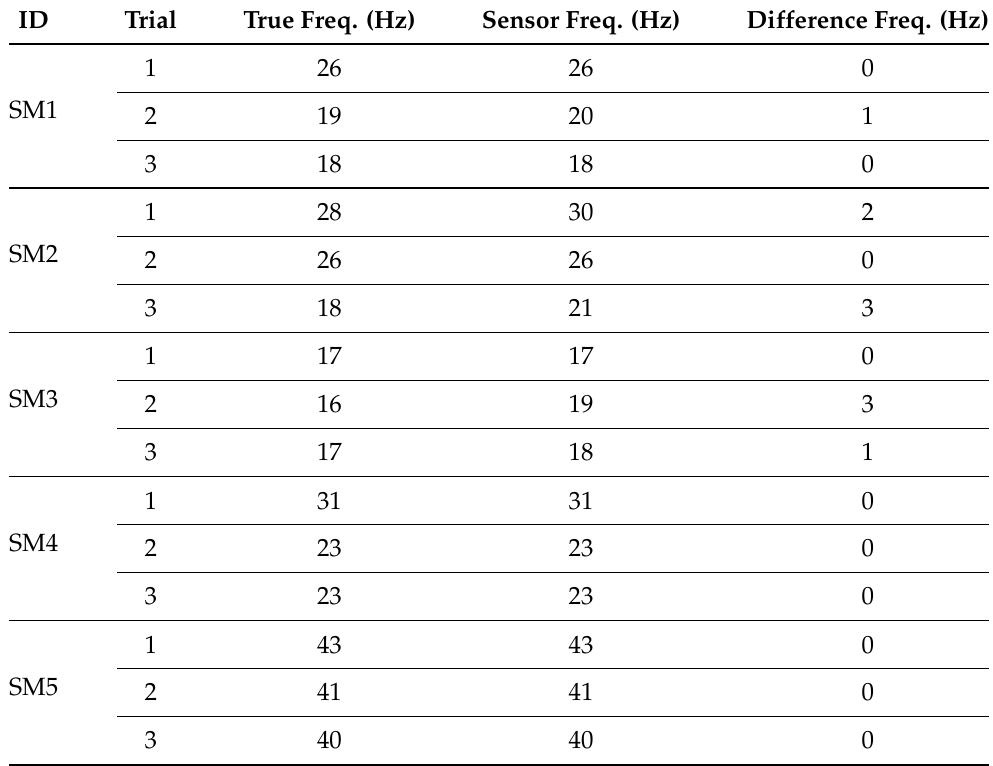
Table 2. Comparison between the frequency response of the sensor to the actual wingbeat frequency of silk moths obtained from high-speed camera footage. “Difference freq.” is the absolute value of the camera frequency minus the sensor frequency. “SM” stands for silk moth.